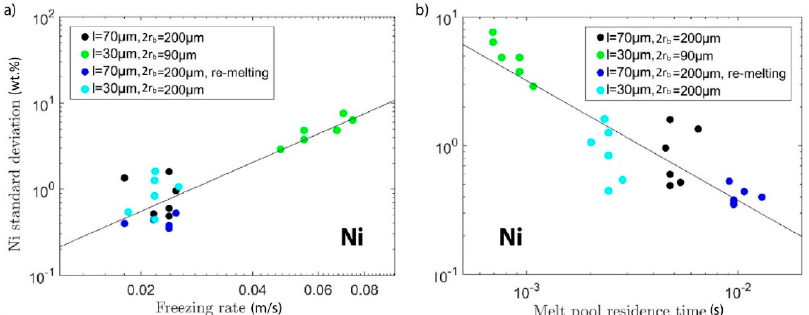
Figure 7. Same plots as in Figure 6, but with the analysis performed for Ni instead of Cr: the relationship between Ni standard deviation (wt %) and freezing rate ( a ) and melt pool residence time ( b